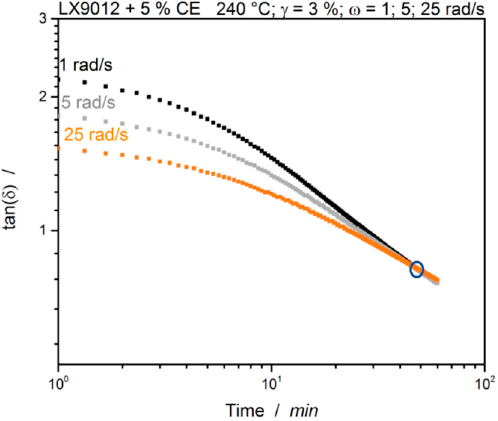
Figure 9. LX9012 with 5% CE measured at 240 °C. tan( δ ) of different simultaneous measured frequencies for the evaluation of the gel-point (highlighted).